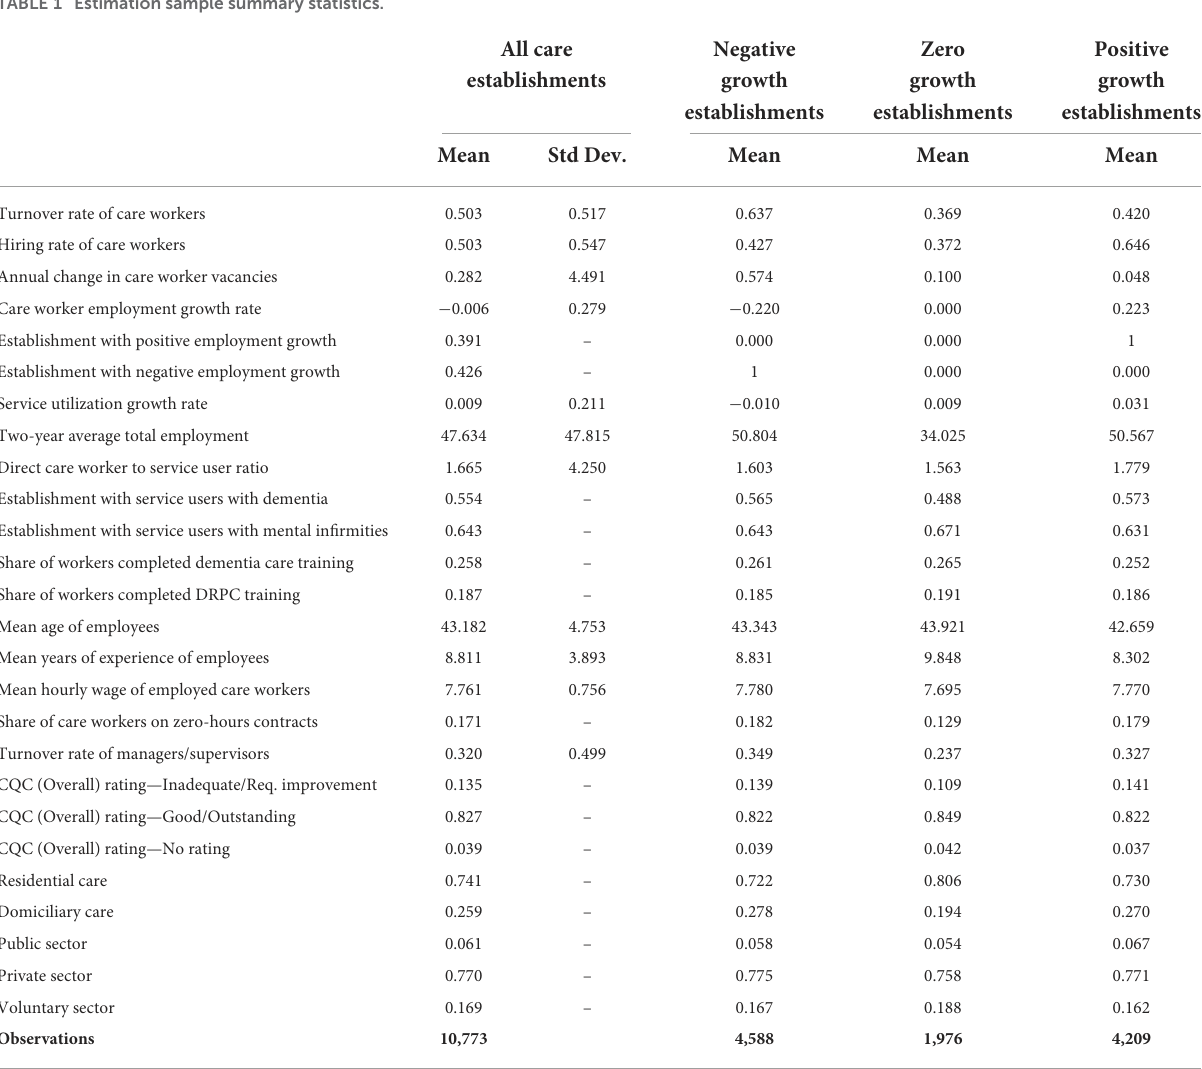
TABLE 1 Estimation sample summary statistics.